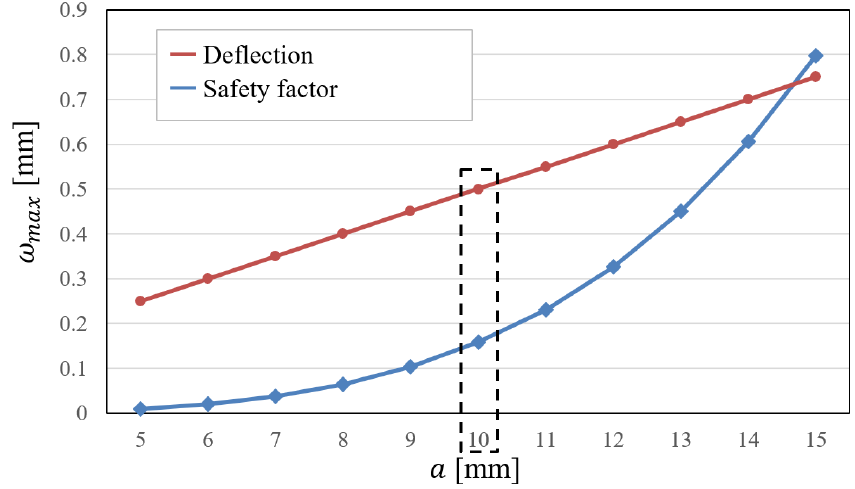
Figure 4. Calculation results of the maximum deflections at different spans.